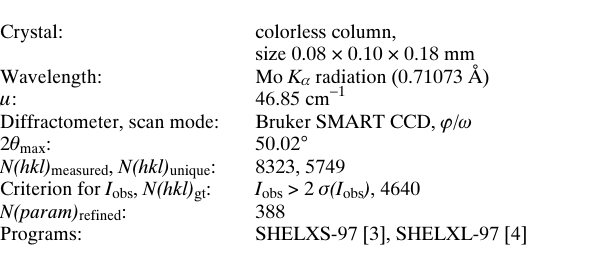
Table 1. Data collection and